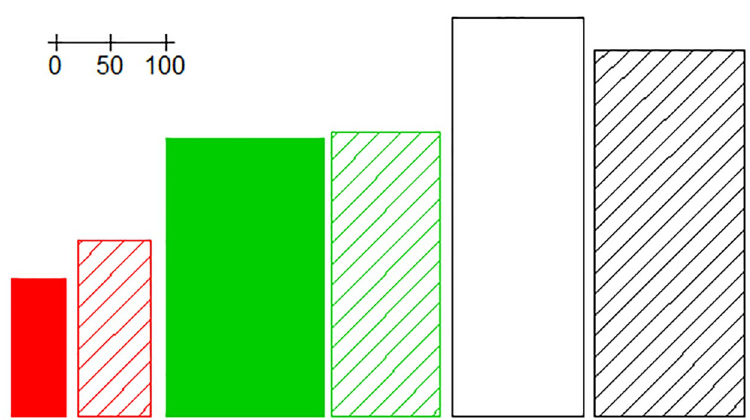
Fig 2. Representative feet of the toy example. The color code of each representant coincides with the color code used in the assignments of Fig 1. The centroids of each cluster are represented by shading lines, while the archetypoids are represented by solid colors. In order to highlight the differences and make them more easily perceptible to the human eye, the percentiles of each representative foot were computed. The rectangles represent the increase or decrease with respect to the median foot measurements, which are: 96 mm (BW) and 241 mm (FL). For example, the percentiles of the first archetypoid are 1 and 2 for each variable, respectively. Therefore, in the plot, it is represented as: 96 � (1